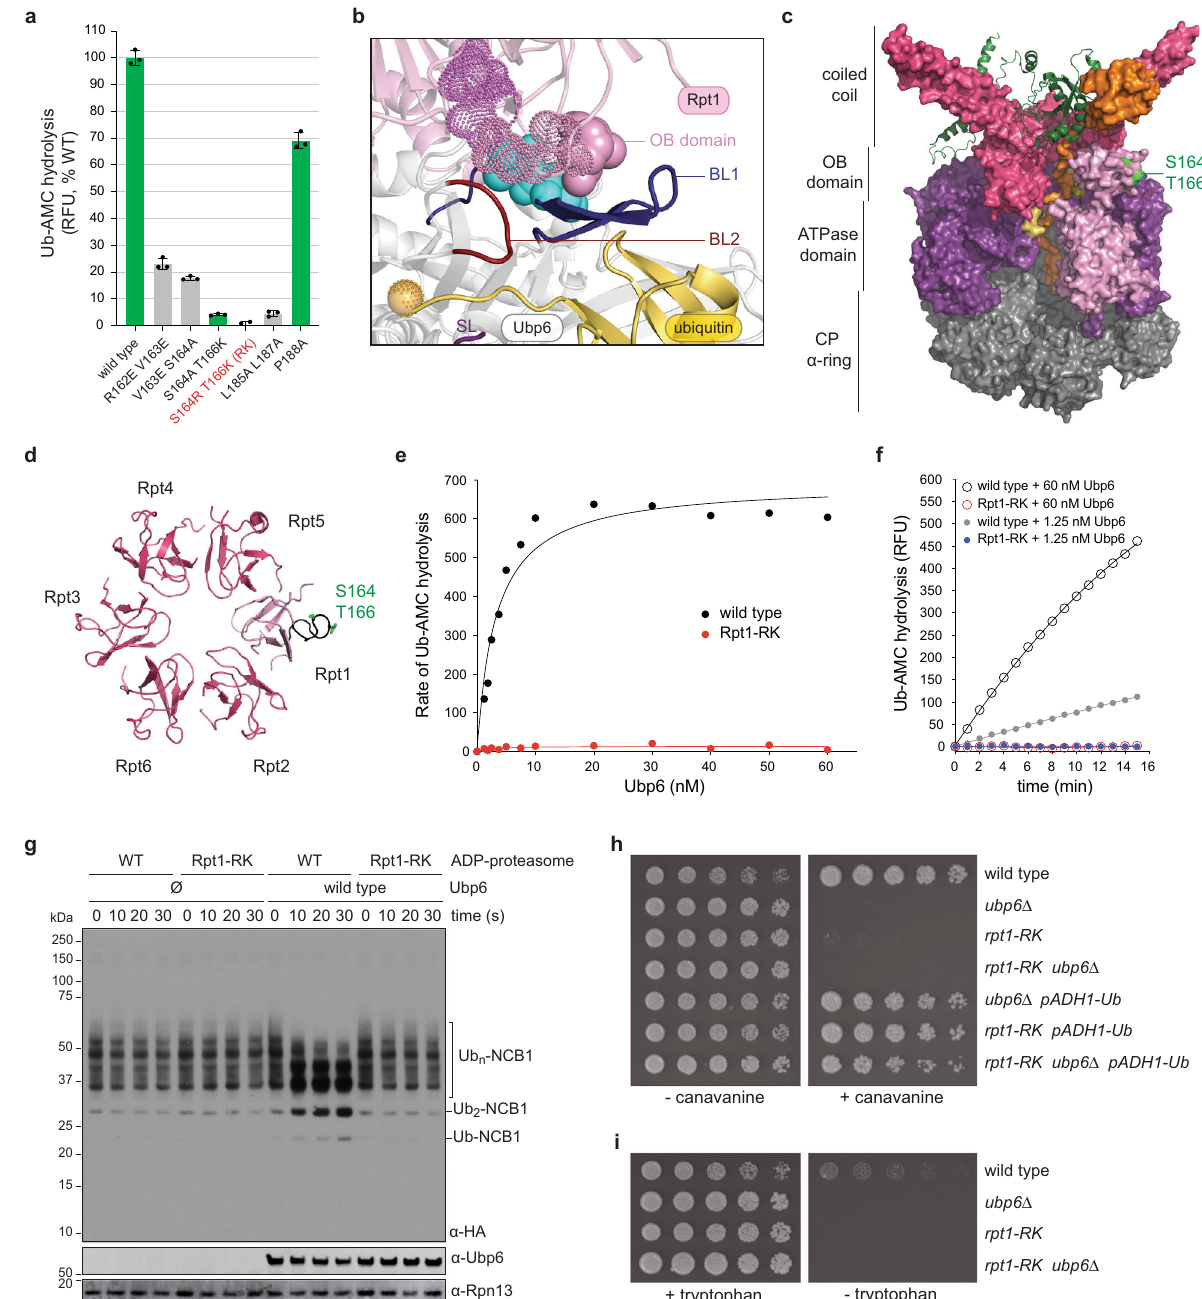
Fig. 3 An Rpt1 mutant defective in Ubp6 activation. a Ub-AMC hydrolysis by Ubp6 in the presence of wild-type and mutant proteasomes. n = 3 independent samples per experiment were examined. Data are presented as mean values ± SD. rpt1-RK is highlighted. Mutants in green showed unperturbed proteasome assembly (see Supplementary Fig. 8); the assembly was impaired for those in gray. b The modeled Rpt1-Ubp6 interface. Cyan, Ubp6 residues I329 and L330. Solid pink, Rpt1 S164 and T166. Stippled pink and violet spheres, other mutated Rpt1 residues (PDB: 7QO3, 7QO4). c Positions of S164 and T166 (neon green) within the OB domain of the ATPase ring. Coiled-coil and OB domains are in rose, ATPase domain in purple, Rpt1 in pink, Rpn11 in green ribbon. Substrate (orange) is passing through RPT pore loops (yellow) into the CP axial channel. Portions of Rpt1 and Rpt2 were removed to reveal the substrate channel. (PDB: 6EF3). d Top view of the OB domain. Rpt1 ’ s L34 loop is in black, residues S164 and T166 in green. (PDB: 6EF3). e The effect of Ubp6 concentration on Ub-AMC hydrolysis in the presence of proteasome (1 nM) puri fi ed from ubp6 Δ hul5 Δ (nominally wild-type) or rpt1-RK ubp6 Δ hul5 Δ strain. Data were fi t to a hyperbolic curve, yielding a K d value of ~3.3 nM and ~2.0 nM for wild-type and Rpt1-RK proteasome, respectively. f Ubp6 activity in the presence of mutant proteasomes. g Deubiquitination of HA-Ub n -NCB1 in the presence of Ubp6 and ADP-proteasomes. h Wild-type, ubp6 Δ , and rpt1-RK mutants were serially diluted and spotted onto agar plates in the presence or absence of canavanine (1.5 μ g/mL). The pADH1-Ub transgene is integrated into the UBP6 locus and expresses ubiquitin from the ADH1 promoter. i Ub-K-Trp reporter stabilization by rpt1-RK mutant. Yeast cells were serially diluted and plated on media containing or lacking tryptophan. Source data are provided as a Source Data